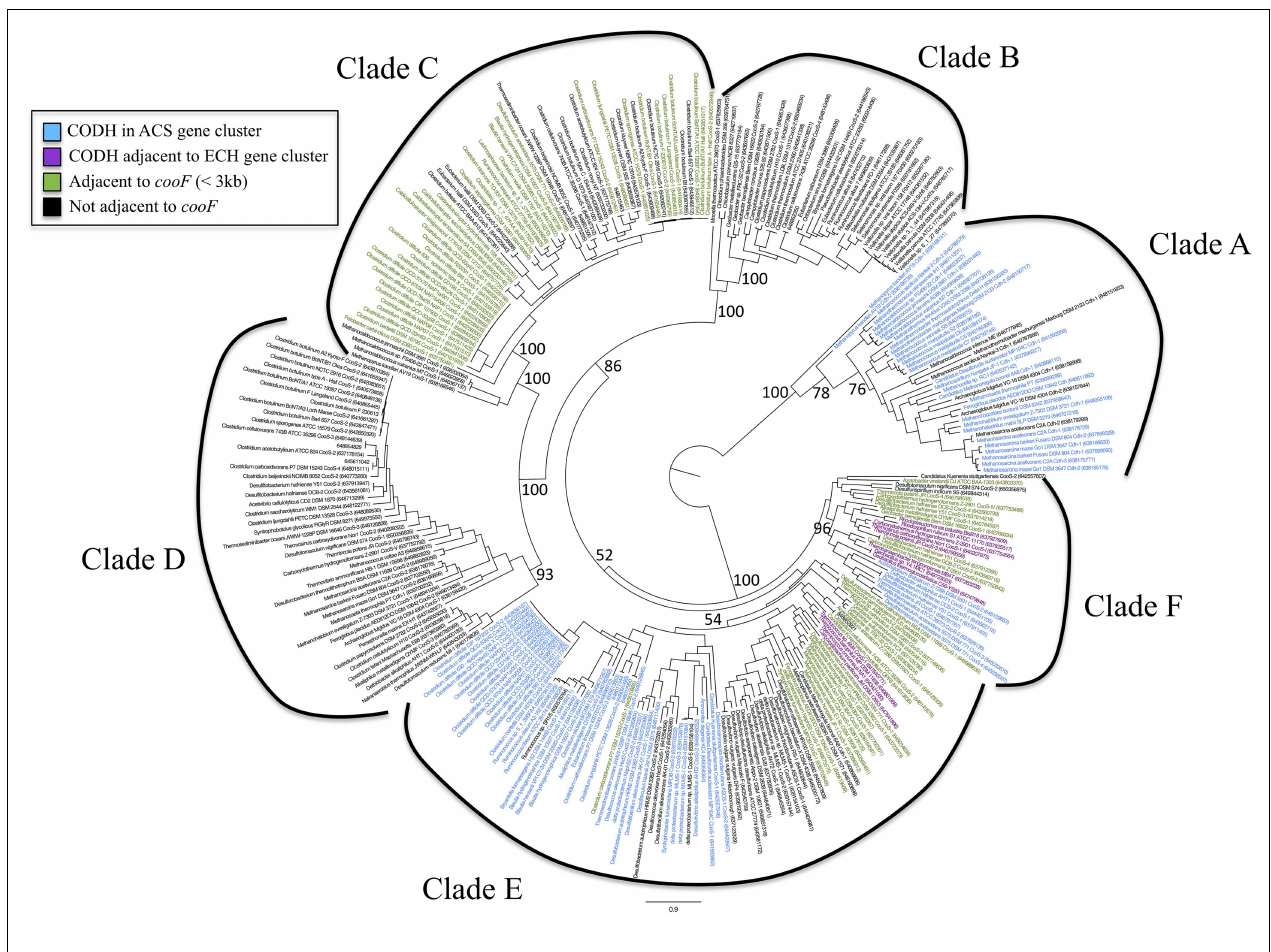
cluster. Purple indicates CODH adjacent to an energy-converting hydrogenase gene cluster. Green indicates that the CODH is adjacent to a cooF gene. Black indicates that the CODH is not linked to a cooF gene. Bootstrap values are shown as a percentage derived from 1000